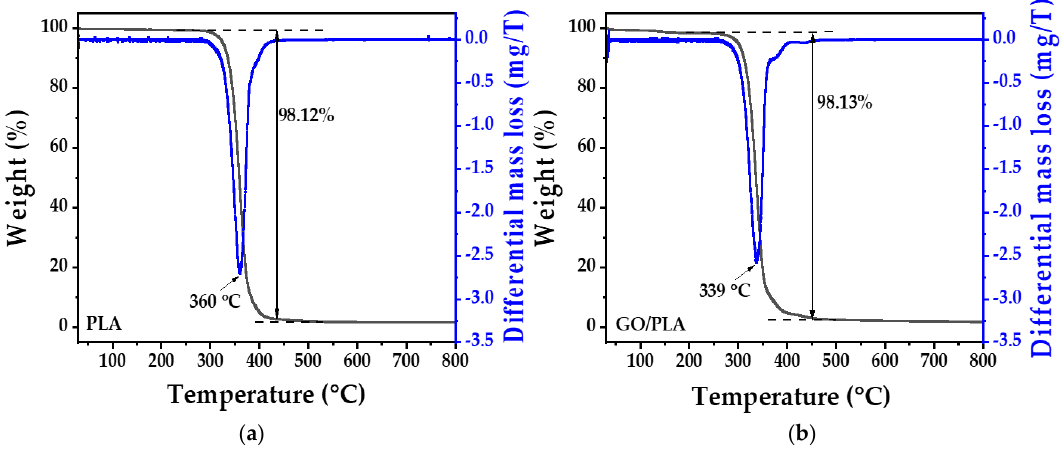
Figure 7. TG and DTG curves of ( a ) PLA and ( b ) GO/PLA.